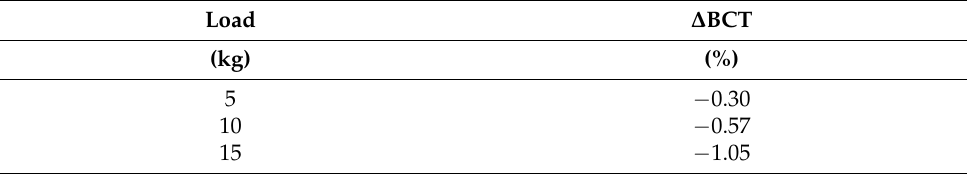
Table 3. Change in the BCT parameter (compressive strength) as a result of increasing the bottom